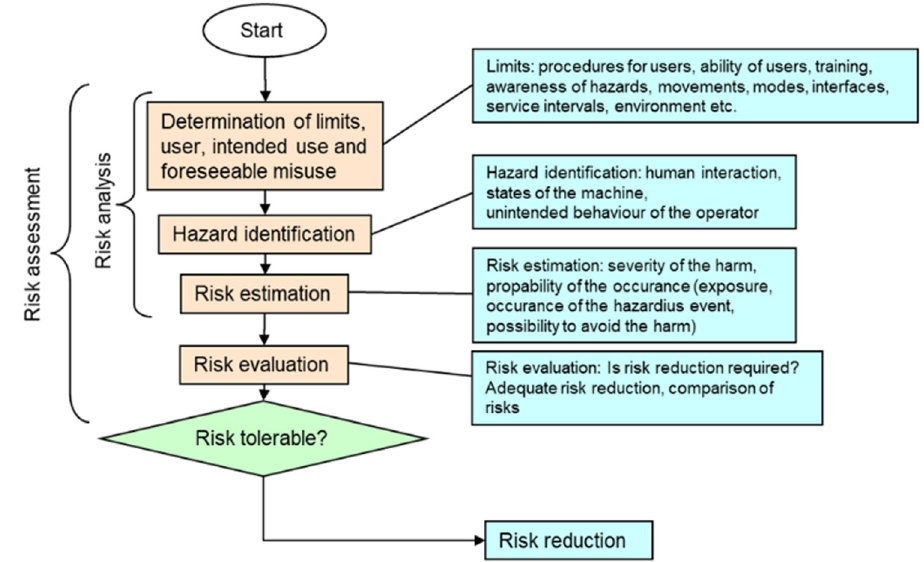
Figure 1: Risk assessment process according to ISO 12100:2010 ( modi fi ed ) [ 20 ]